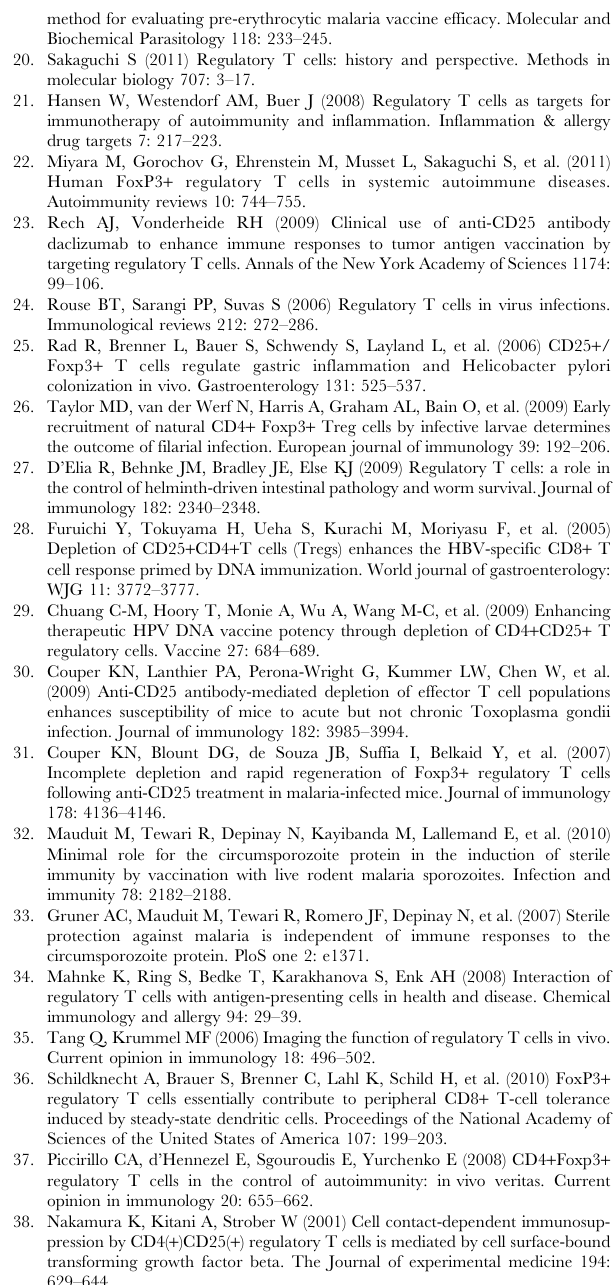
Figure S1 Kinetics of T reg depletion in DEREG